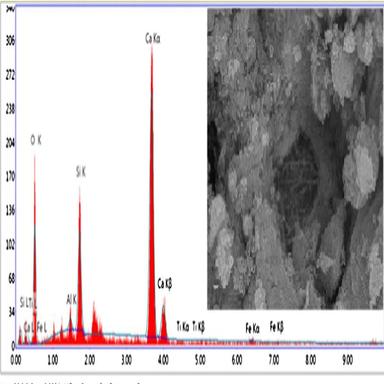
SEM image and EDX analysis of solidified cement with slag and titanate nanofibers.